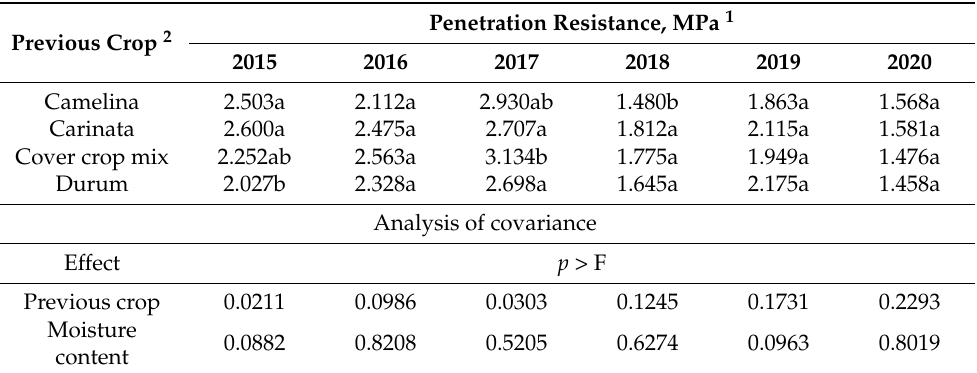
Table 3. Analysis of covariance results showing the effect of previous crop on mean soil penetration